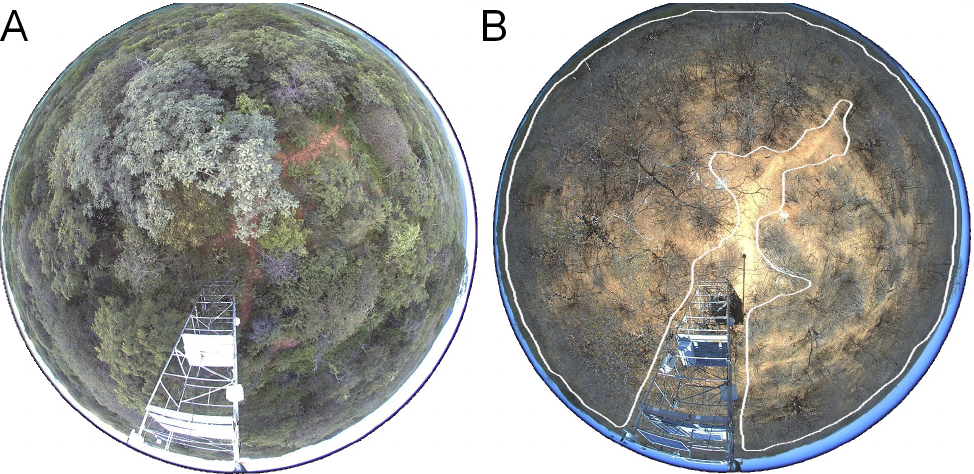
Figure 4. Hemispherical image used for the proximal remote sensing phenological analyses at the study site, PE-Brazil; ( A ) In the rainy season day of year (DOY) 107, 2018. ( B ) In the dry season DOY 256, 2018; the area selected in white represents the entire vegetation sampled as the region of interest (ROI) of the community for the extraction of phenological